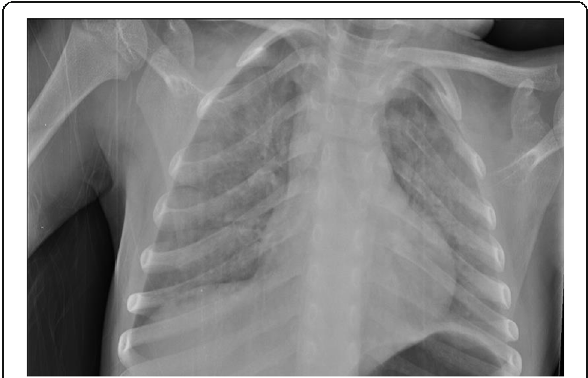
Fig. 2 Postoperative posterior-anterior chest